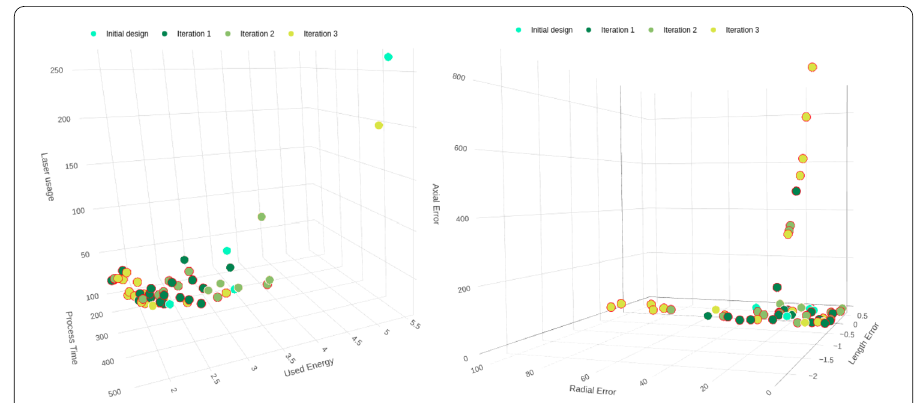
Figure 13 Case Study 2: PMs values of initial experimental design (cyan), iteration k = 1 (dark green), iteration k = 2 (olive green), and iteration k = 3 (yellow). The red circle around the dots mark the runs belonging to the final pareto front. Left: PMs 1, 2, and 3. Right: PMs 4, 5, and